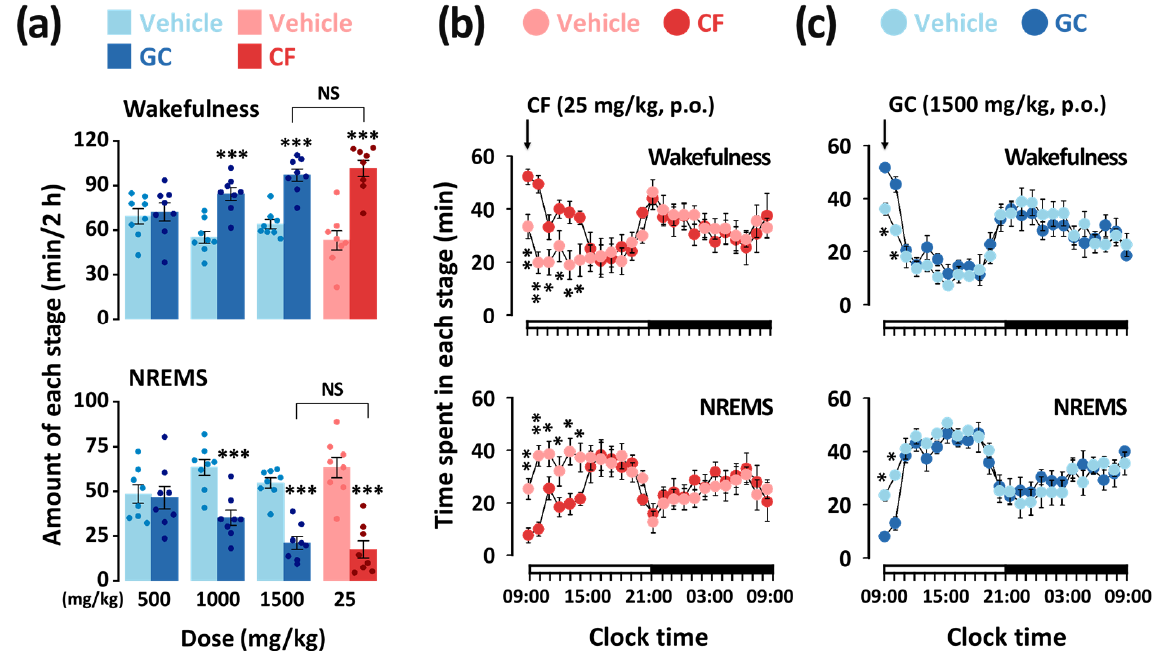
Figure 4. ( a ) Effects of GC and caffeine on wakefulness and NREMS during the 2 h period after administration. Effects of caffeine ( b ) and GC ( c ) on time-course changes in wakefulness and NREMS over a period of 24 h. Light color bars indicate the baseline day (vehicle). Light and deep color circles indicate the baseline day (vehicle) and experimental day (caffeine or GC), respectively. Each circle represents the hourly mean ± SEM ( n = 7–8) of wakefulness and NREMS. Each value represents the mean ± SEM of each group. ( n = 7–8). * p < 0.05, ** p < 0.01, *** p < 0.001, significantly different from the vehicle (unpaired Student’s t -test). CF, caffeine; GC, G. cambogia peel extract; NREMS, non-rapid eye movement sleep; SEM, standard error of mean; NS, no significant difference.